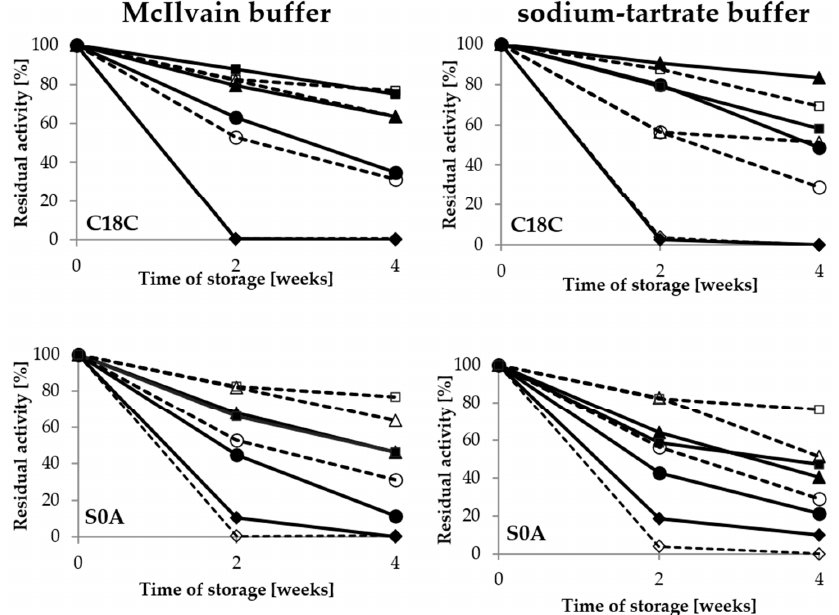
Figure 6. Stability of adsorbed laccase activity during 4-week storage in the McIlvain buffer and the sodium-tartrate in the range of pH from 3 to 6; immobilised LAC—filled, free LAC—empty: pH 3—rhombus, pH 4—circle, pH 5—triangle, pH 6—square.